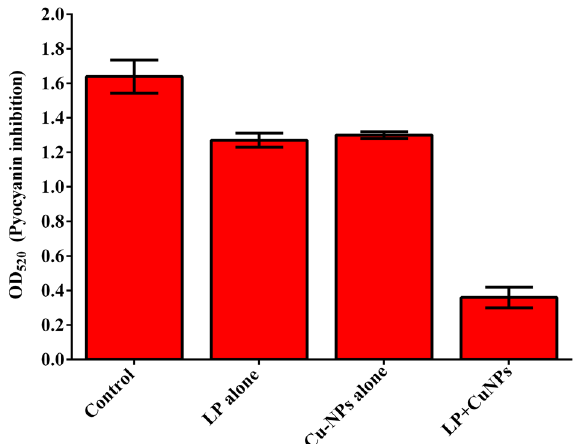
Figure 7. Inhibition of Pyocyanin. All data points represent the mean ± SD from at least three independent experiments.